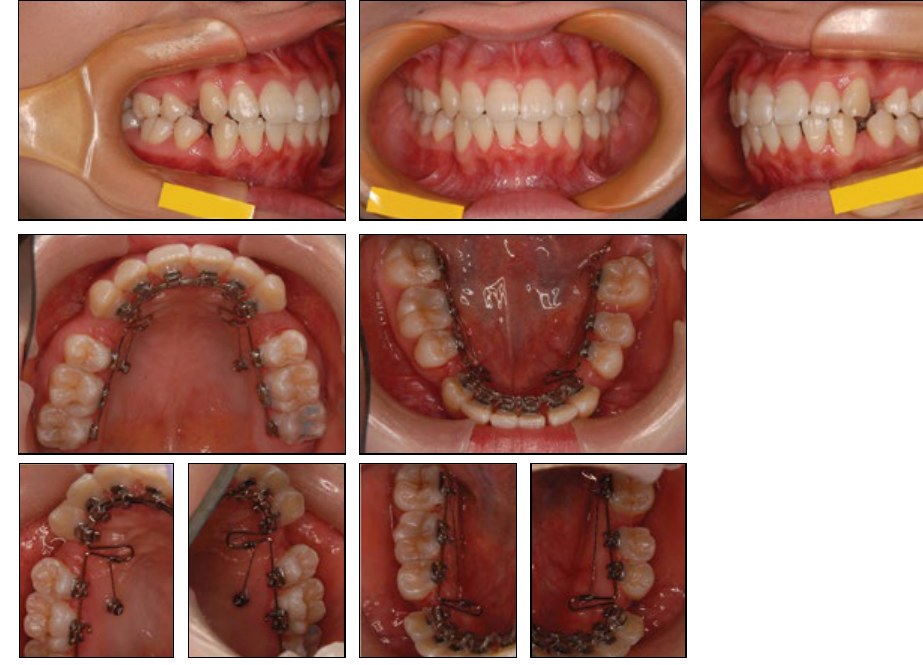
Figure 8. Closing phase of treatment